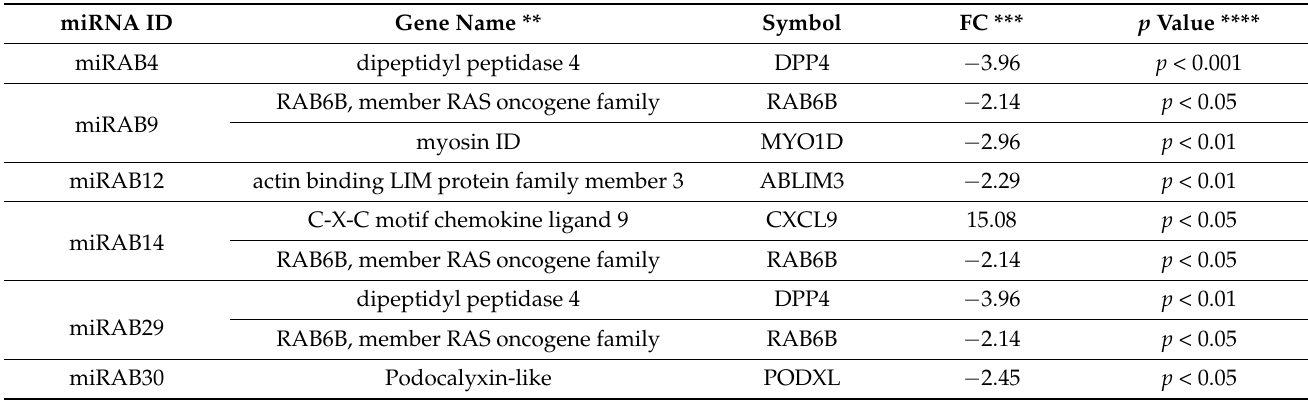
Table 2. Expression levels of the predicted genes for each miRNA in the gene expression in Microarray analysis *. miRNA